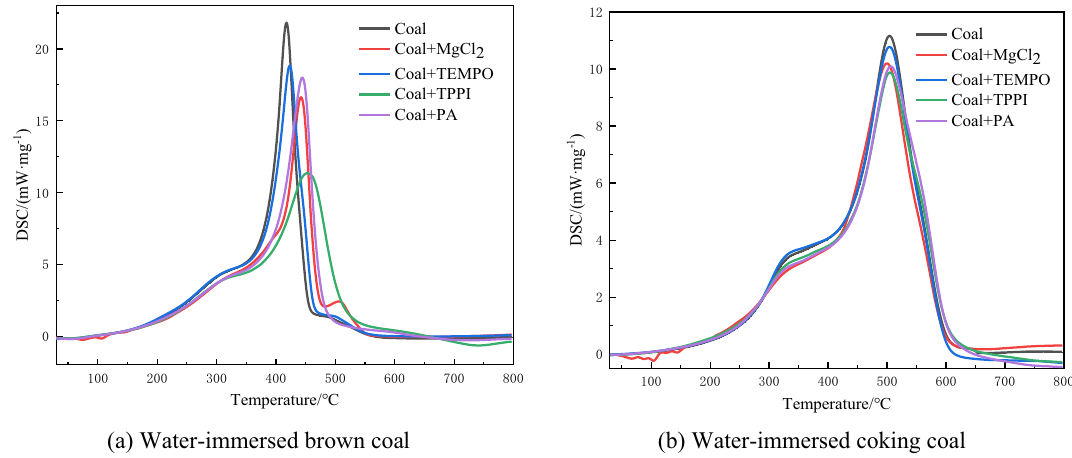
Figure 5. Thermal characteristic curves of water-immersed coal samples with different metamorphic degrees.